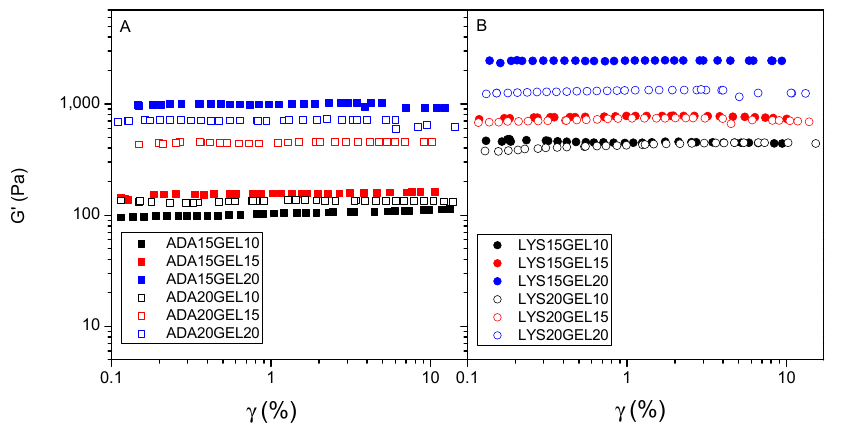
Figure 5. Amplitude strain sweep for hydrogels of alginate derivate samples crosslinked with 10 (black), 15 (red), and 20 (blue) (% w / v ) of gelatin: 15% ( w / v ) of ADA (filled square) and 20% ( w / v ) of ADA (square) ( A ); 15% ( w / v ) of ʟ -lysine − functionalized ADA (filled circle) and 20% ( w / v ) of ʟ -lysine − functionalized ADA (circle) ( B ).